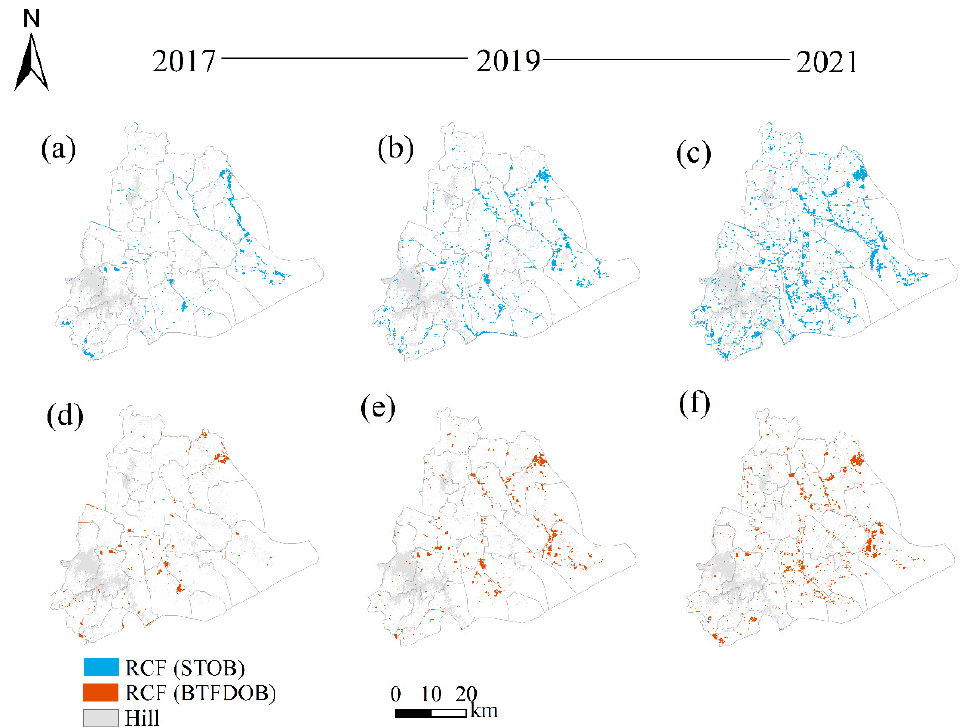
Figure 9. Comparison of the RCF maps derived from the two methods in three years. ( a – c ) RCFs identified by the STOB method; ( d – f ) RCFs identified by the BTFDOB method.